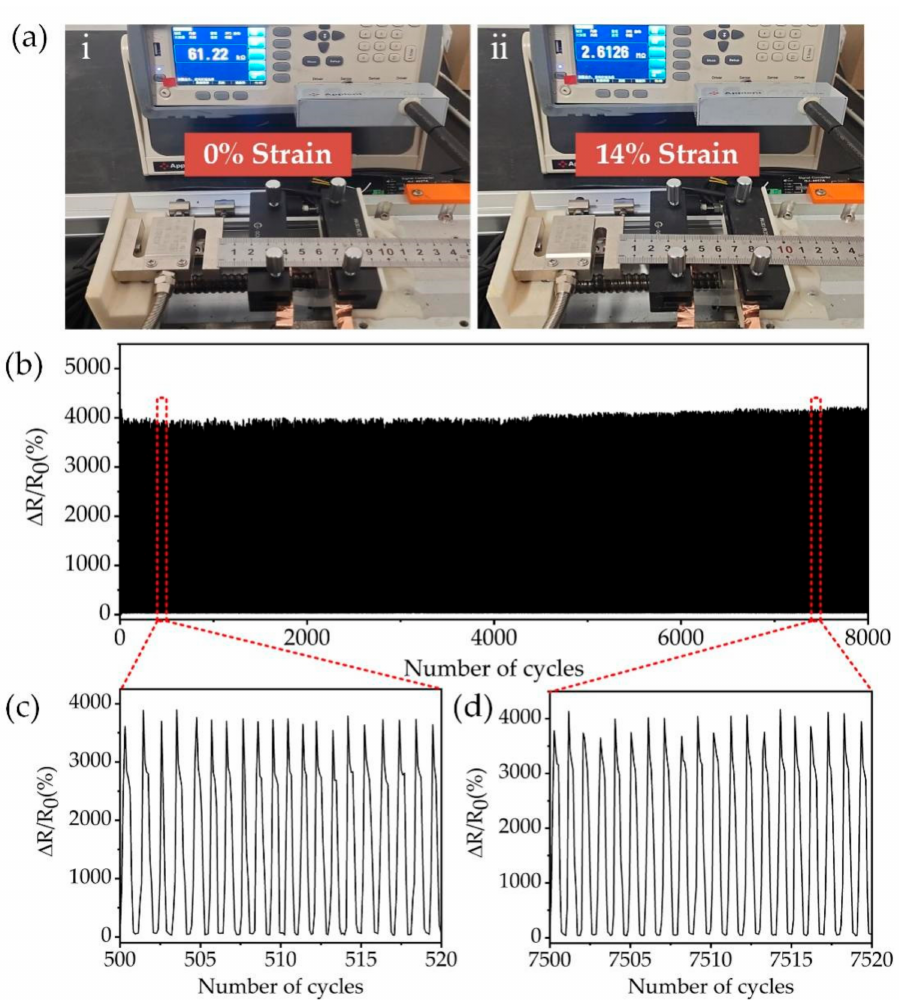
Figure 5. Stability performance of the strain sensor with the embedded MWCNT network. ( a ) Resis- tance changes of the sensor during 10,000 stretch-release cycles. ( b ) Resistance changes between 500 and 520 stretch-release cycles. ( c ) Resistance changes between 7500 and 7520 stretch-release cycles. ( d ) Resistance changes at 0% and 14%